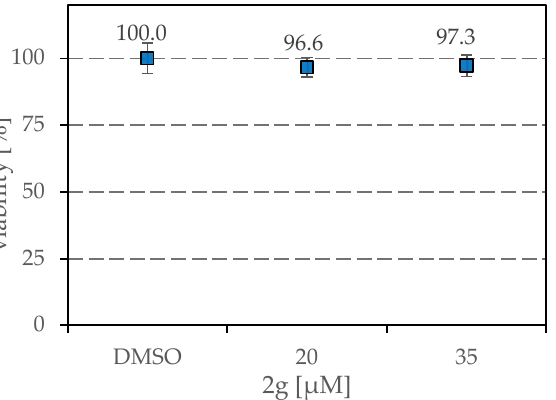
Figure 3. Exclusion of 2g -induced necrosis in Nalm-6 cells. Nalm-6 cells were treated with 20 µ M and 35 µ M 2g for 1 h. The determination of viability was performed via the LDH release assay. Three replicates were carried out per concentration. The mean values ± SD are shown; no significance was found ( p < 0.05 vs. DMSO, t